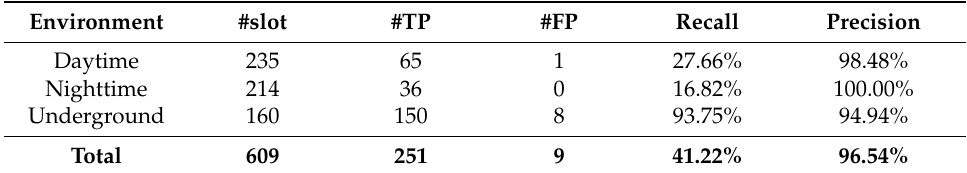
Table 4. Performance of the method in [5].